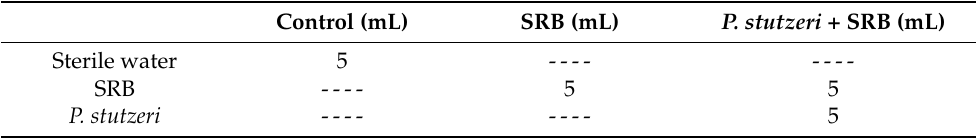
Table 1. The inocula volumes of the three experimental groups. Control (mL) SRB (mL) P. stutzeri + SRB (mL) Sterile water 5 - - - - - - - - SRB - - - - 5 5 P. stutzeri - - - - - - - -